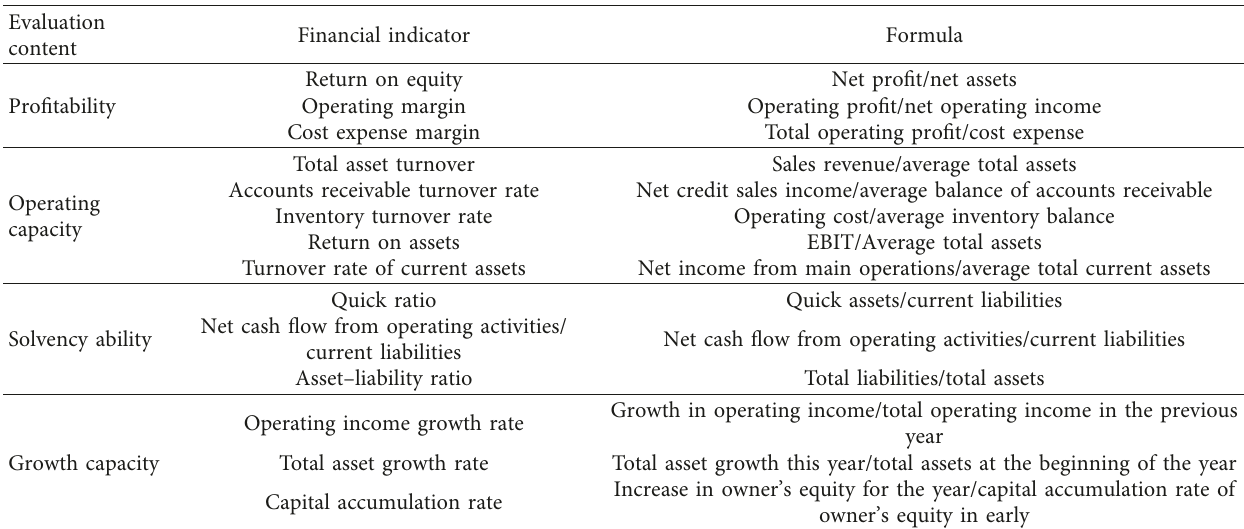
Table 2: Variable selection.